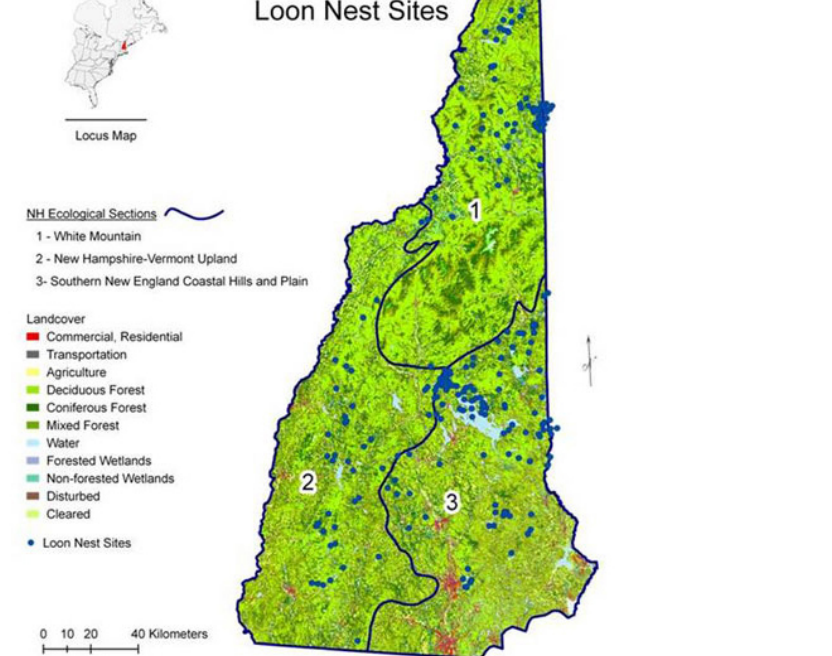
Fig. 2. Land cover map for the State of New Hampshire, indicating ecological sections (ecoregions), the distribution of lakes, and Common Loon nest site